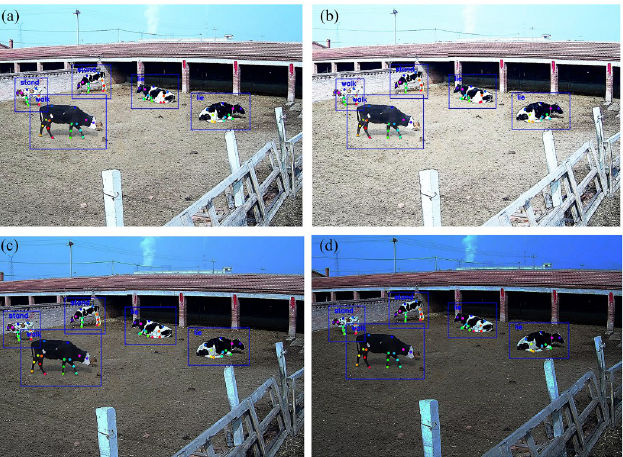
Fig 8. The detection result at different brightness values. (a) and (b) represent the influence of increasing the brightness by 25% and 50%. (c) and (d) represent the influence of decreasing the brightness by 25% and 50%.